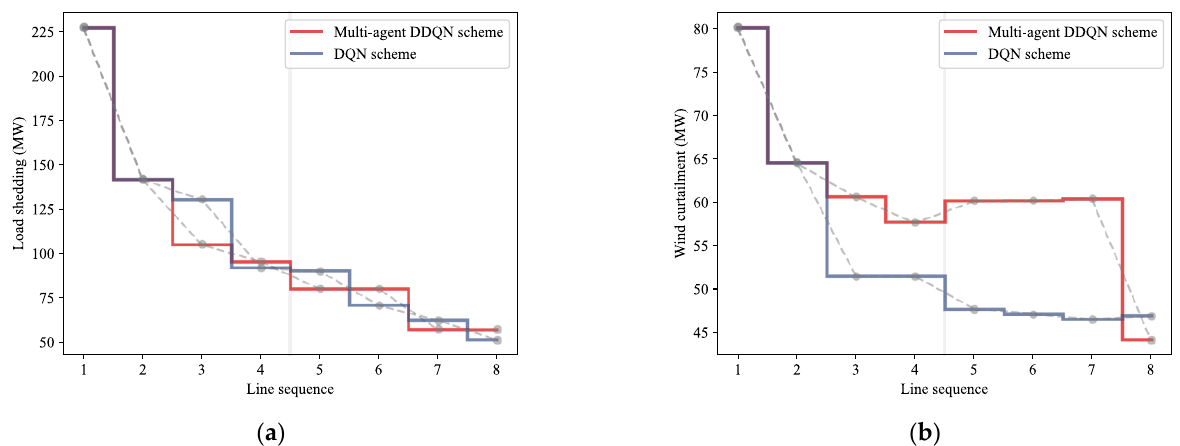
Figure 11. ( a ) Load shedding comparison of multi-agent DDQN and DQN. ( b ) Wind curtailment comparison of multi-agent DDQN and DQN.